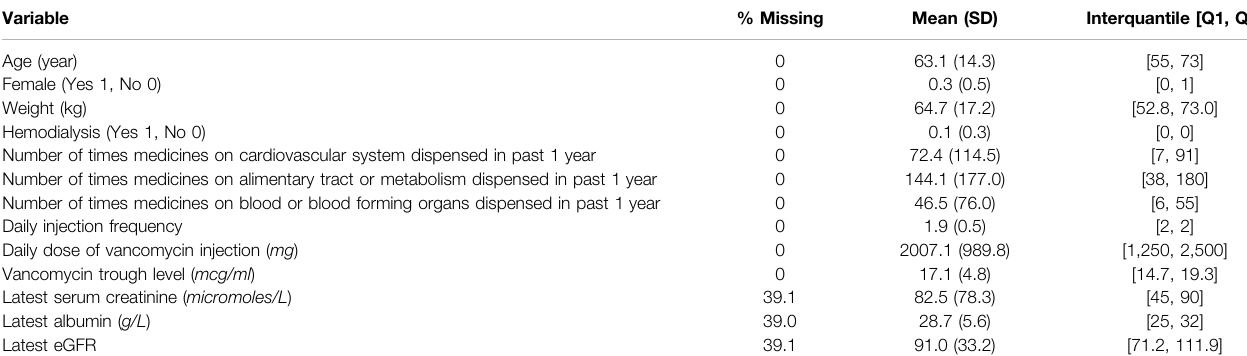
TABLE 3 | Descriptive statistics of the study cohort. Variable